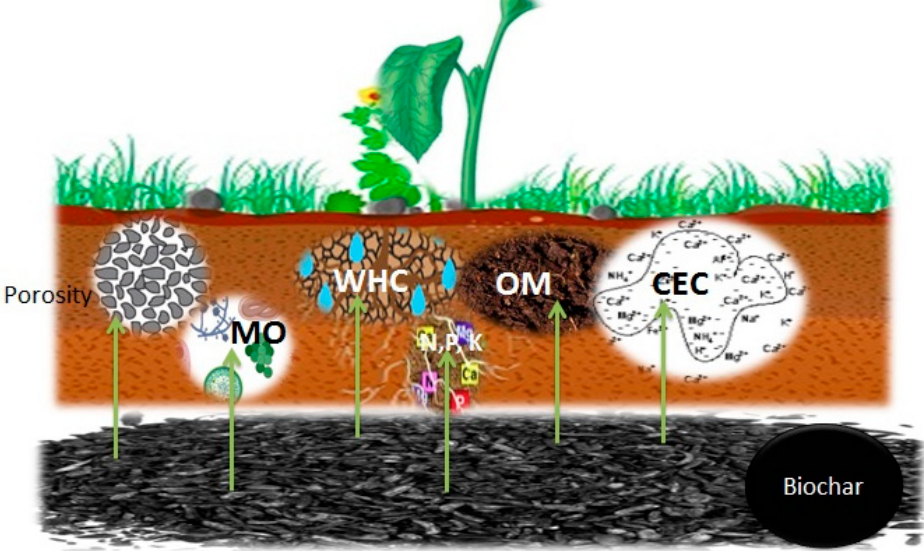
Figure 6. Beneficial effects of biochar on soil. OM = organic matter; WHC = water holding capacity; CEC = cation exchange capacity.